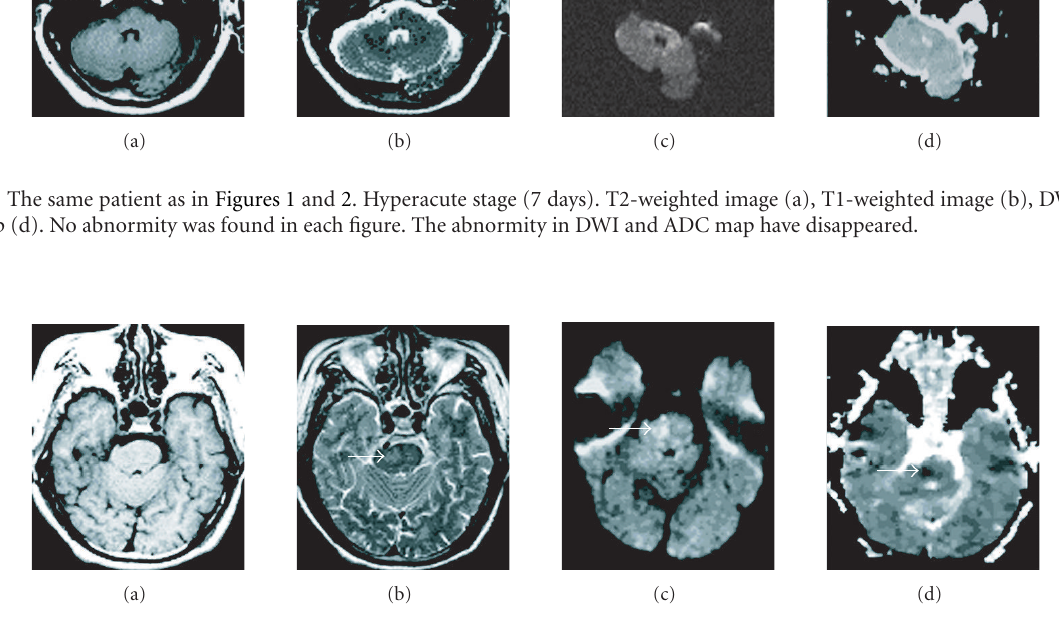
Figure 4: A 68-year-old male, brainstem infarction in acute stage (14 hours). The images are T1-weighted image (a), T2-weighted image (b), DWI (c), and ADC map (d), respectively. No clear abnormal signal can be seen in T1-weighted image, but slightly hyperintense signal in T2-weighted image, hyperintense signal in DWI, and hypointense signal in ADC